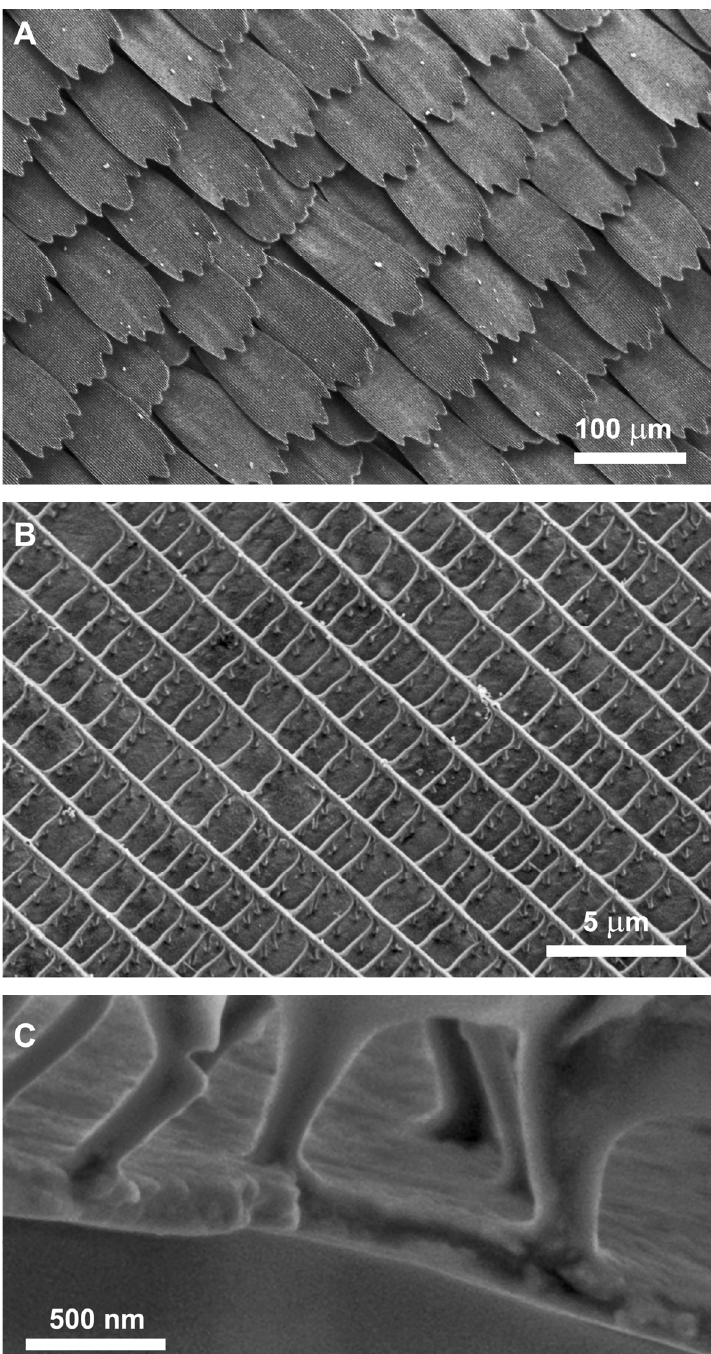
Figure 4. Scanning electron micrographs of Euphaedra neophron violaceae under different magnifications. ( A ) Dorsal hind wing scales generating violet colour, ( B ) longitudinal ridges and connecting cross ribs raising from the unstructured lamina of an individual scale of the region shown in ( A ). ( C ) Scanning electron micrograph of dorsal wing surface colour-generating scale cross-section, lamina, and trabeculae.